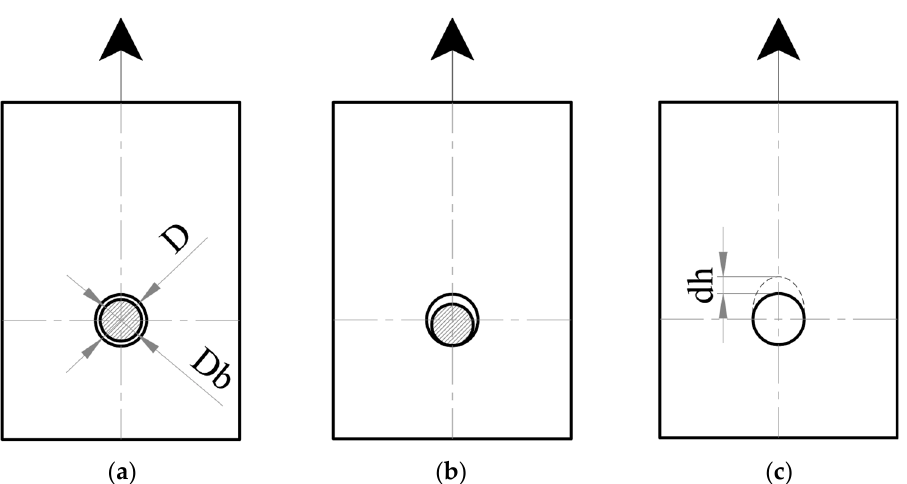
Figure 6. Bolt hole locking; ( a ) bolt hole before locking, ( b ) bolt hole after locking, and ( c ) bolt hole